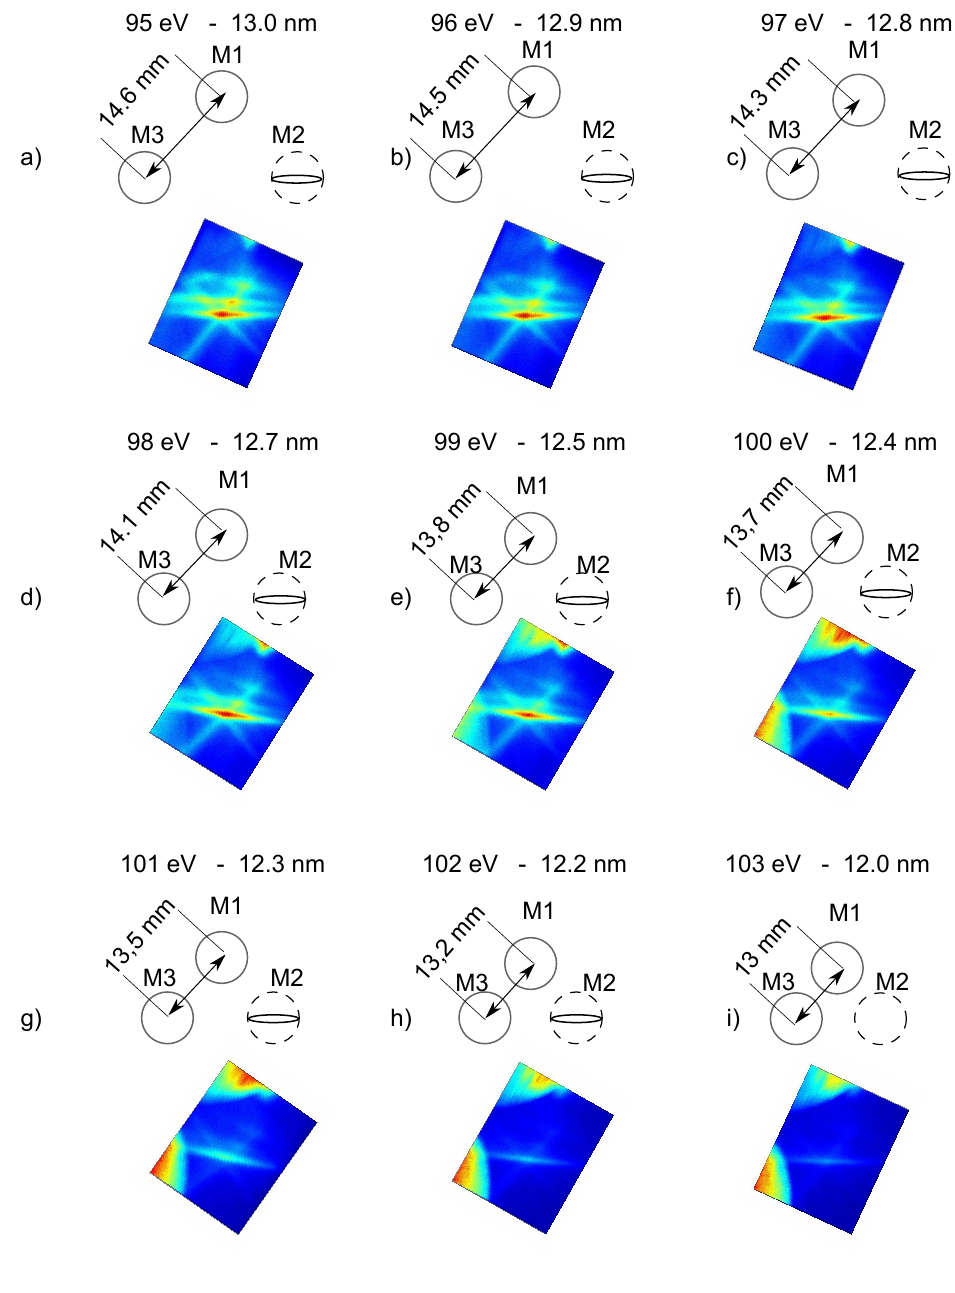
Figure 8. Selection of experimental pattern acquisitions at various wavelengths and simulated patterns as a consequence. Two effects are observed: firstly, ( a – i ) the distance spot-to-spot varies, being larger at (a) and shorter at (i). Secondly, the polarizer M2 , which is oriented horizontally, acts as a horizontal spatial filter and leads to an elliptical spot (shown inside the dashed